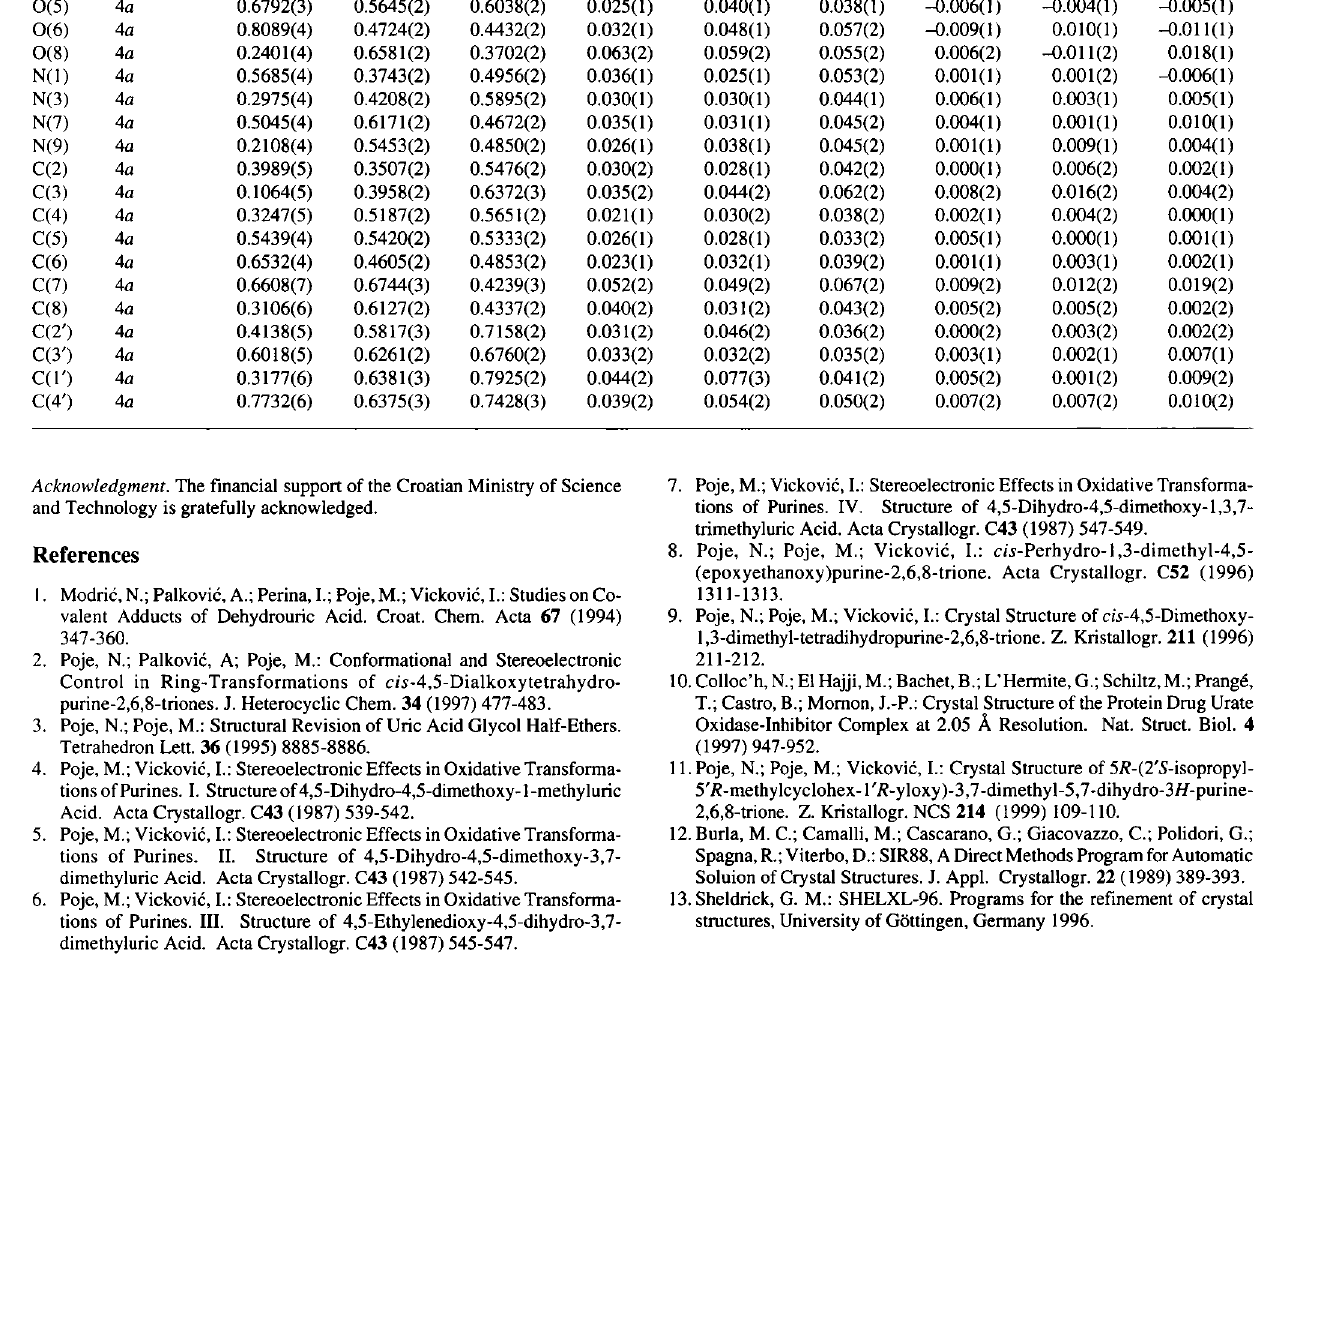
Table 3. Atomic coordinates and displacement parameters (in Ä 2